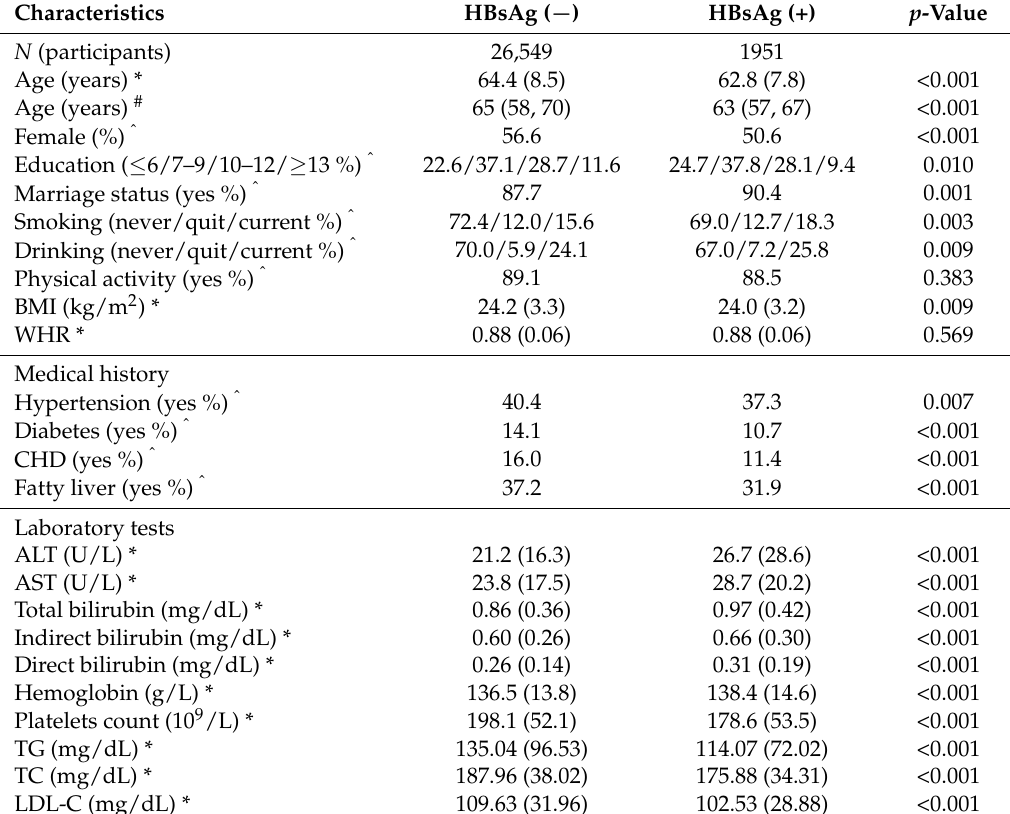
Table 1. The characteristics of 28,500